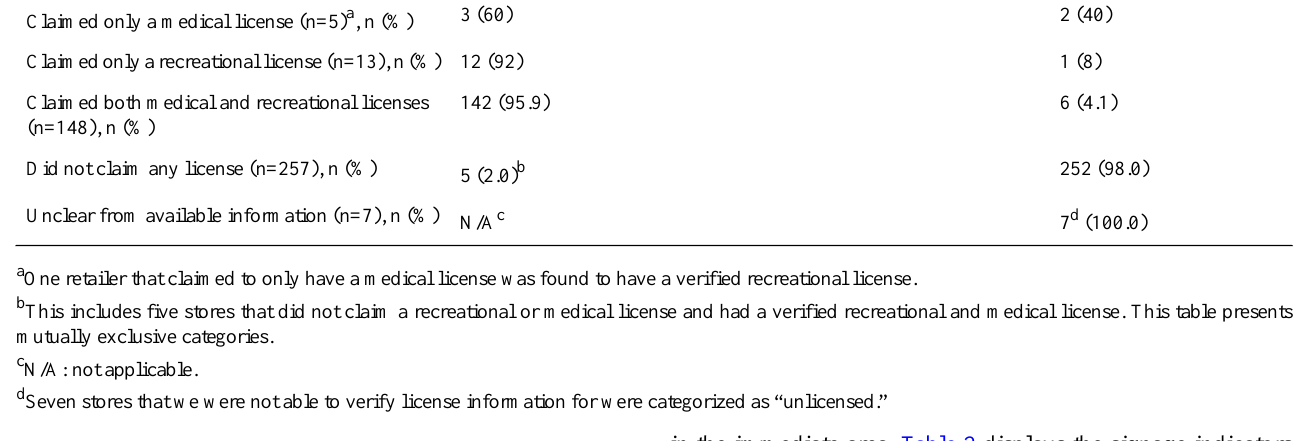
Table 1. Cannabis outlets by license claim status and by verification of license categories (Table includes cell counts and column percentages). (n=162)Online claims about licensure by outlet and medical outlets